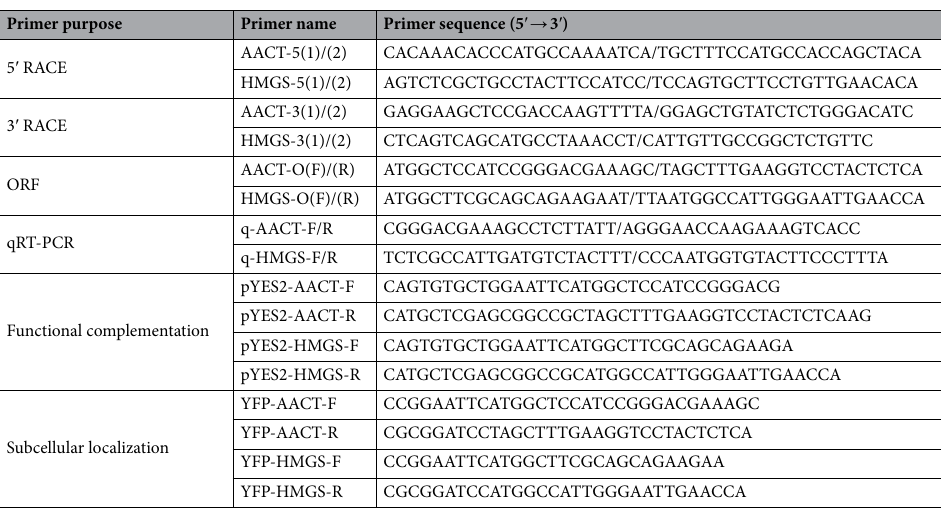
Table 3. Specific primers used in this